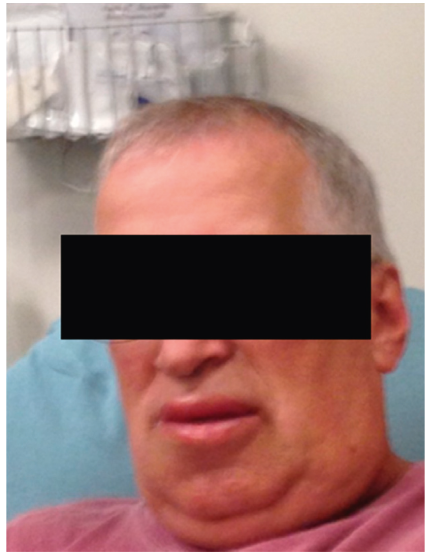
Figure 1: Patient with symmetric lip swelling of upper and lower